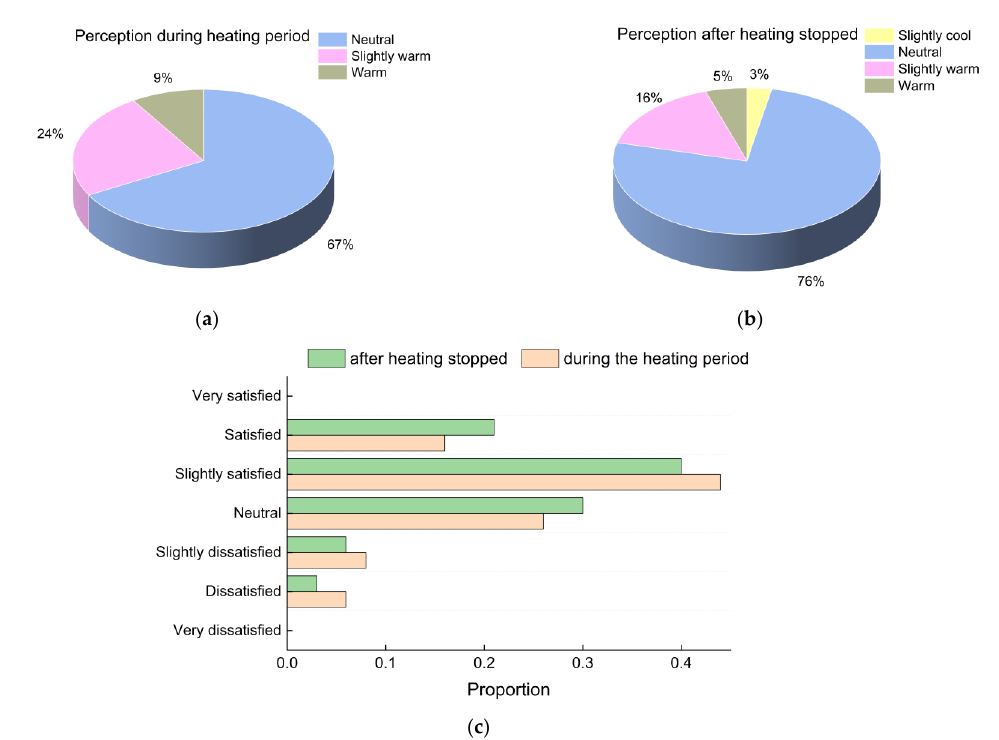
Figure 5. Subjective evaluation of temperature: ( a ) perception during the heating period; ( b ) percep- tion after heating stopped; ( c ) satisfaction proportions. According to the measured RH data, central heating also had an effect on the indoor humidity levels. As shown in Figure 6, during the heating period, 61% of the students felt that the environment was dry, including 3% of them feeling very dry. However, after the heating stopped, the proportion of students feeling that the environment was dry de- creased to 54%, while satisfaction with the humidity environment increased from 19% to 32%. In sum, the students’ satisfaction with humidity levels also improved somewhat af- ter the central heating stopped.